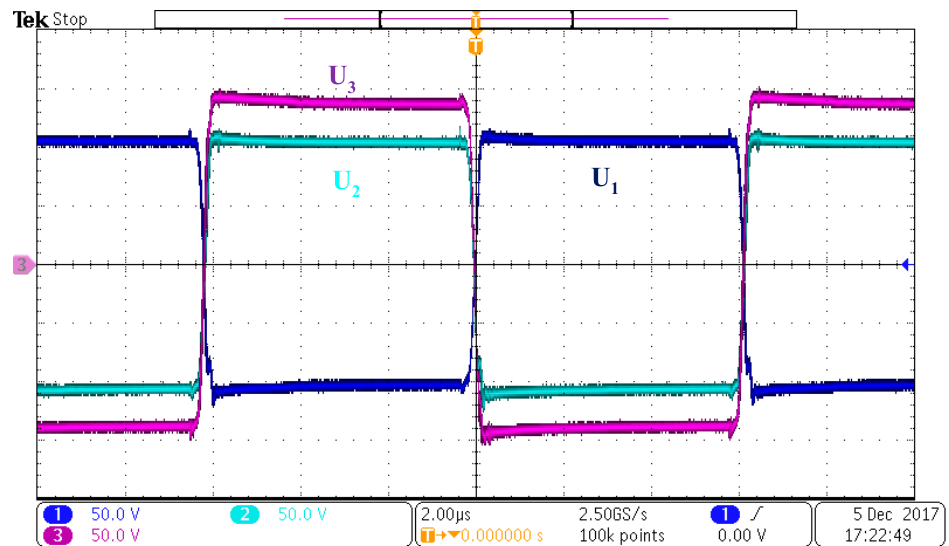
Figure 14. Voltage waveforms on the inductors L 1 – L 3 (100% of output power)—Measurement.